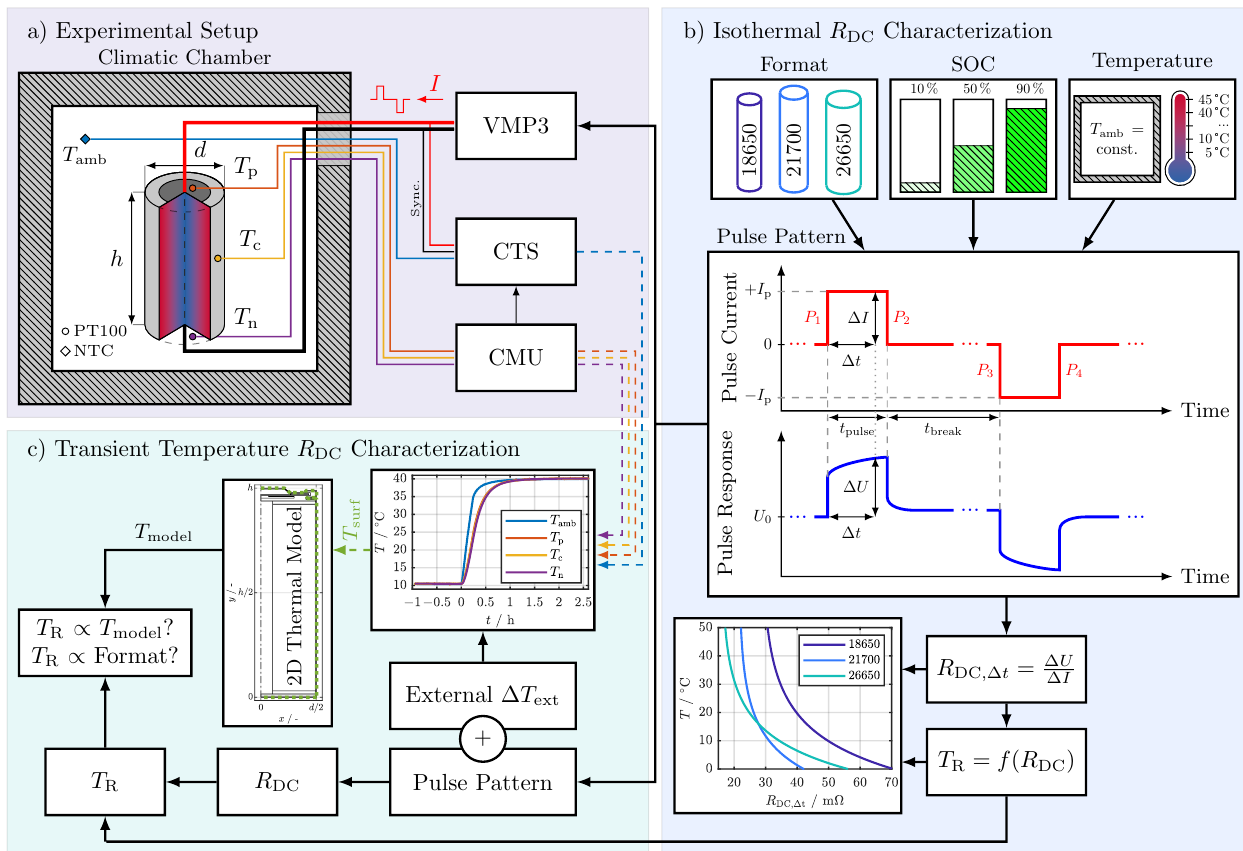
Figure 1. Study overview. ( a ) Experimental setup: climatic chamber for temperature control, temper- ature sensor placement on investigated cells (temperature at the positive terminal ( T p ),